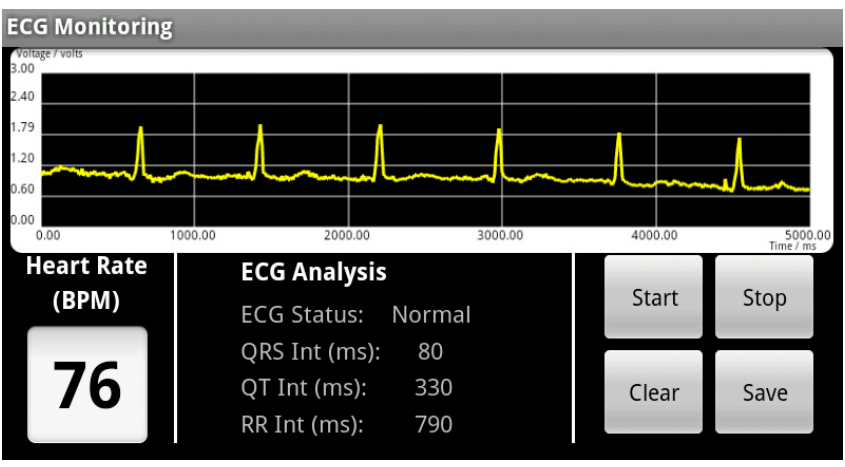
Figure 13. Screen capture of the real time ECG monitoring system.